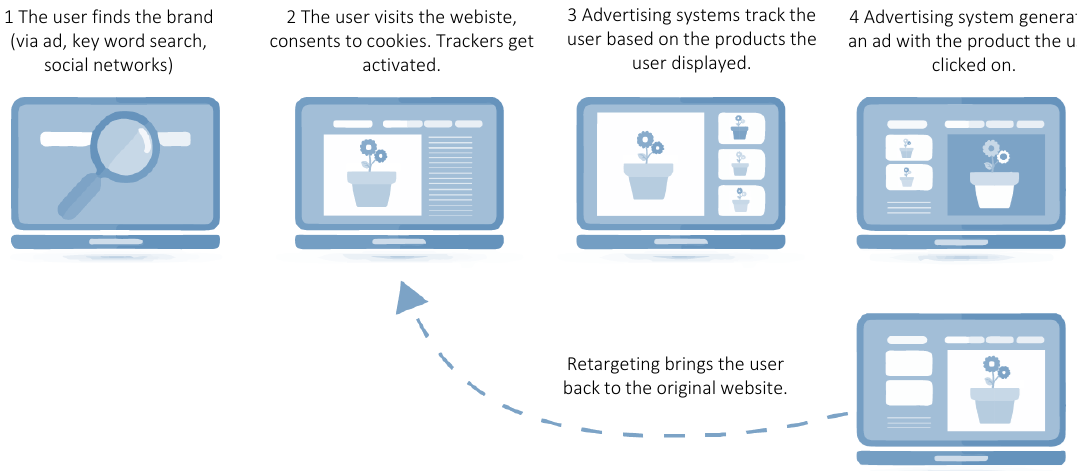
Figure 2. Dynamic retargeting mechanism in